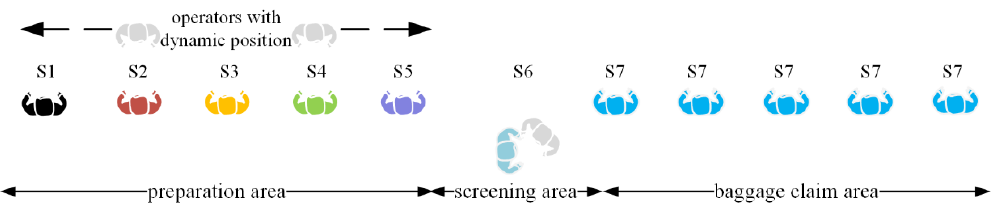
Figure 3. Example of a model state with passenger states covered.